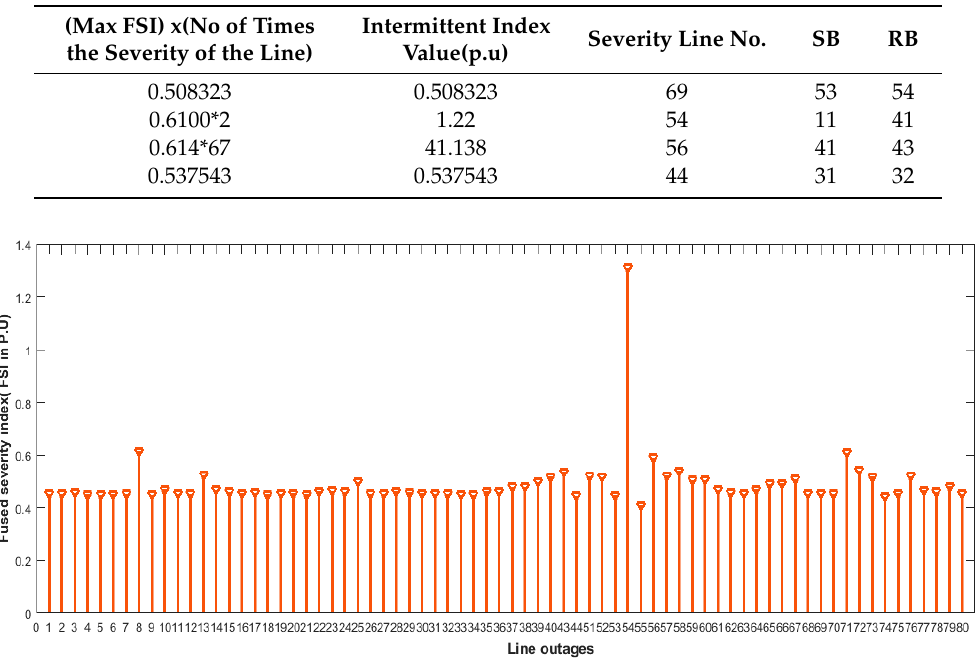
Figure 6. Maximum fused severity index values for various line outages.